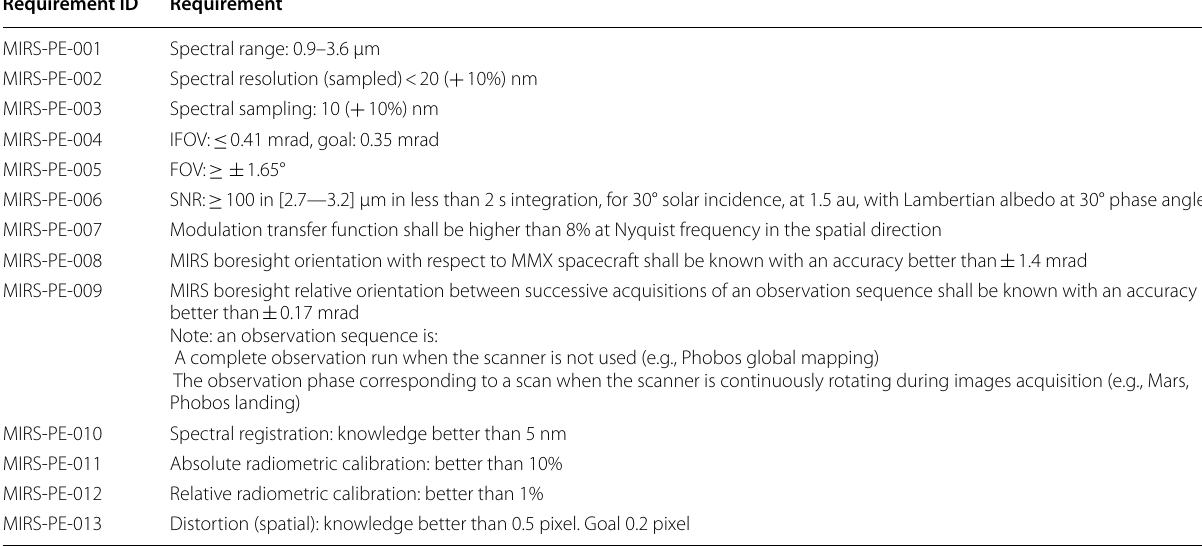
Table 2 MIRS performance